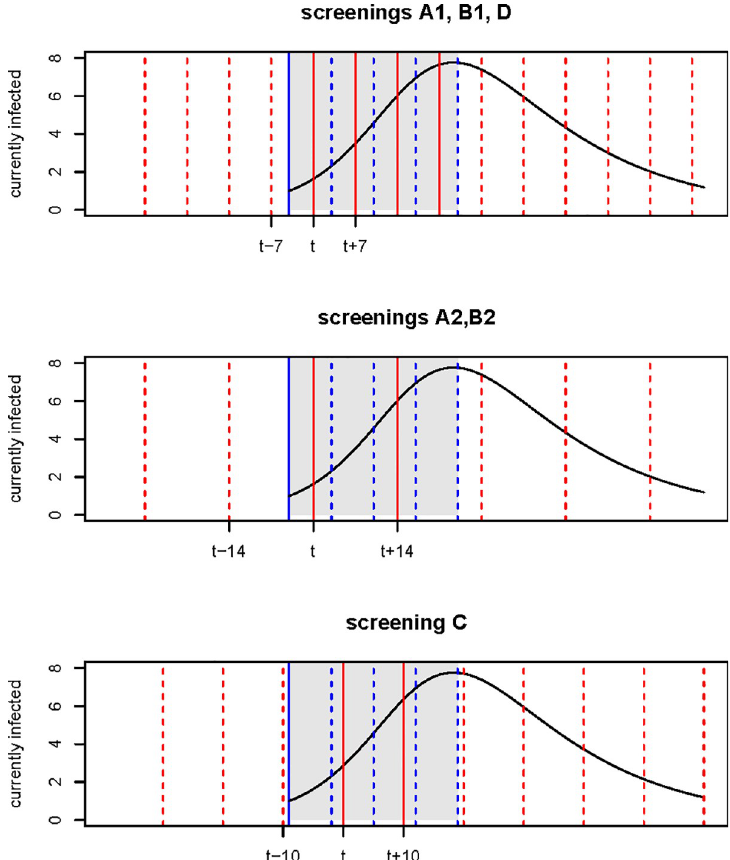
Fig 1. Example of an epidemic curve and its intersection with the screening plans (A1, A2, B1, B2, C, D). Dashed and solid red lines: evaluations carried out on the class according to the screening plans; Solid blue line: beginning of the epidemic; Grey area: time window on which the assessment is made (4 weeks from the beginning of the epidemic); Dashed blue lines: 1, 2, 3 and 4 weeks from the beginning of the epidemic; Solid red lines: evaluations carried out on the class within four weeks from the beginning of the